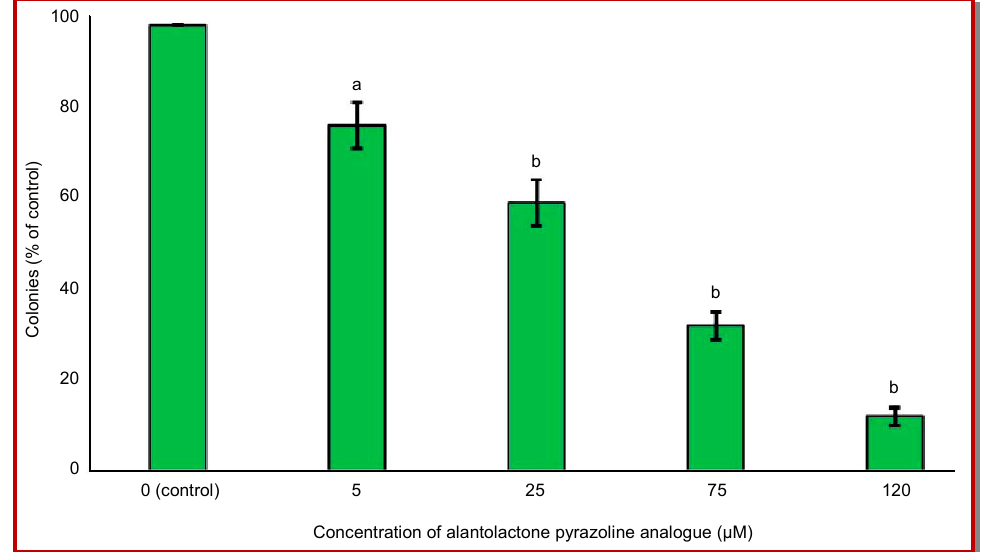
Figure 2: Inhibitory effect of alantolactone pyrazoline analogue (APA) on human non-small cell lung cancer cells. The colony formation assay of NSCLC cells treated with APA at indicated doses. Data are shown as the mean ± SD of three independent experiments by analysis of Student’s t test. a p< 0.05, b p< 0.01, vs 0 µM (control)